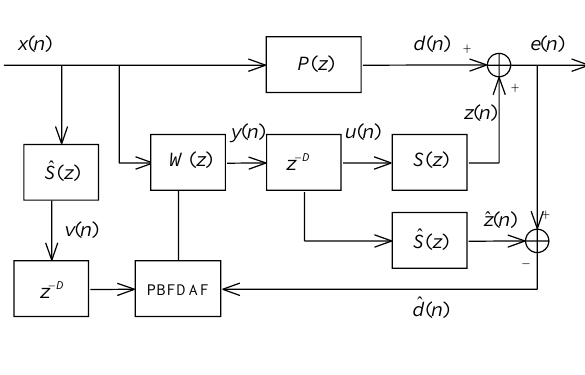
Figure 3. FPBMFxLMS